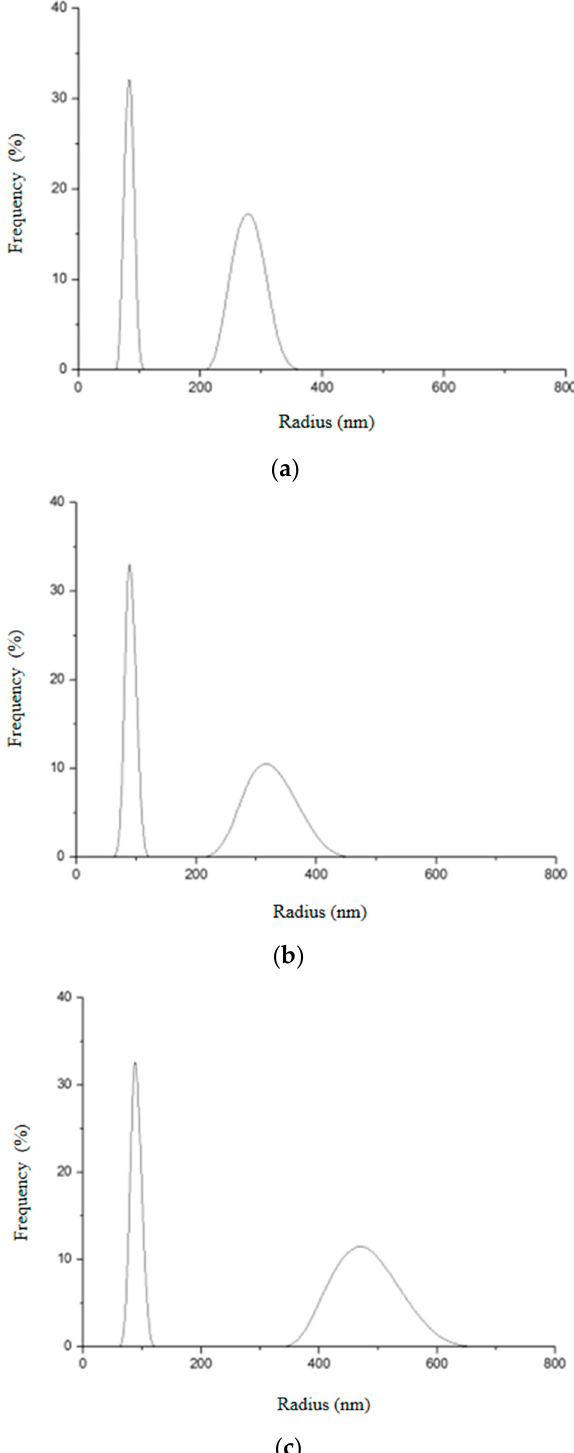
Figure 15. Hydrodynamic radius distribution measured in triplicate ( a – c ) for Gd 2 O 3 :Eu 3+ nanoparti- cles, indicating that they tend to form clusters of different sizes in aqueous solution.